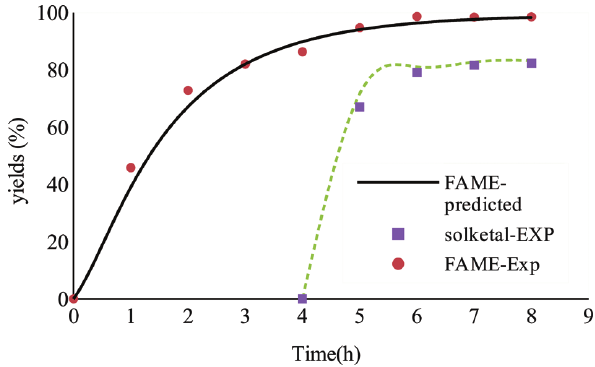
Figure 6: conversion of predicted and experimental values for reactive coupling of (solketal and FAME yield): two stage process, at 7:1 of acetone to oil molar ratio, 50°C, 10:1 of methanol to oil molar ratio and 0.5 of catalyst to oil molar